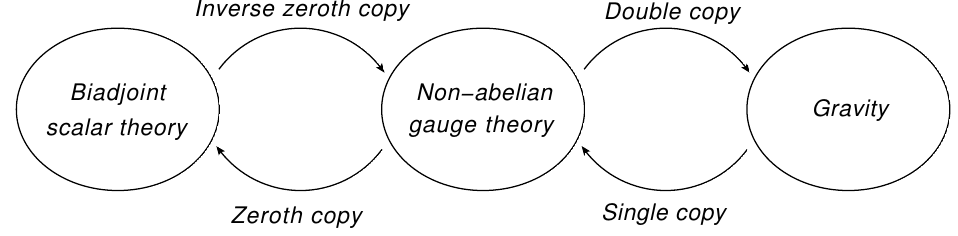
Figure 1 . The di(cid:11)erent theories related by the double, single and zeroth copies. where ~ c a 0 is a second colour vector, that is potentially associated with a di(cid:11)erent gauge group to that of c a . As shown in ref. [48], eq. (2.5) is a solution of a linearisation of